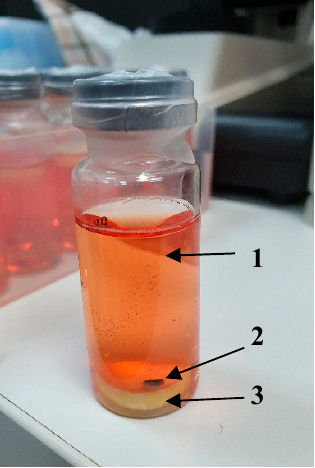
Figure 7. The appearance of the vial, which contains the model system of the eye-derived segment cultivation ( 1 —cultivation medium; 2 —eye-derived segment; 3 —cryogel sponge).